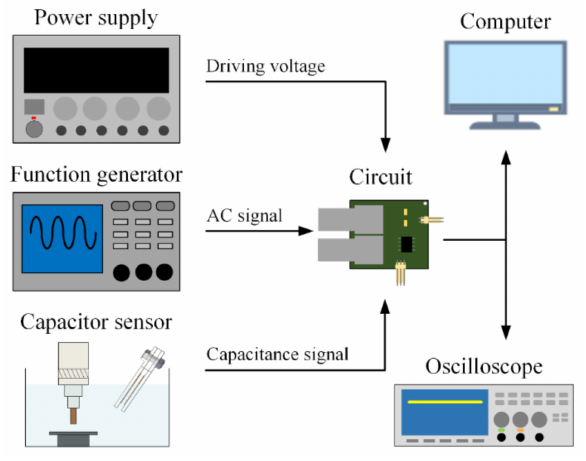
Figure 4. Schematic of the experimental